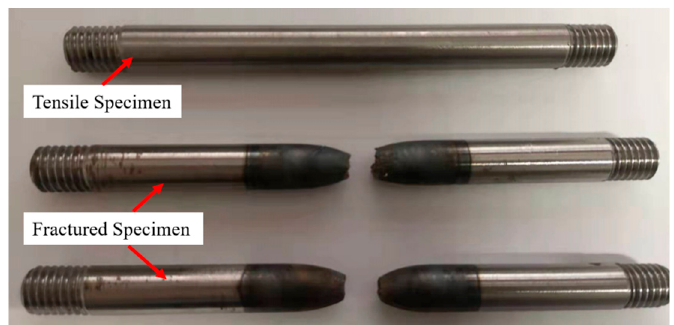
Figure 3. Picture of the sample during the tensile experiment.